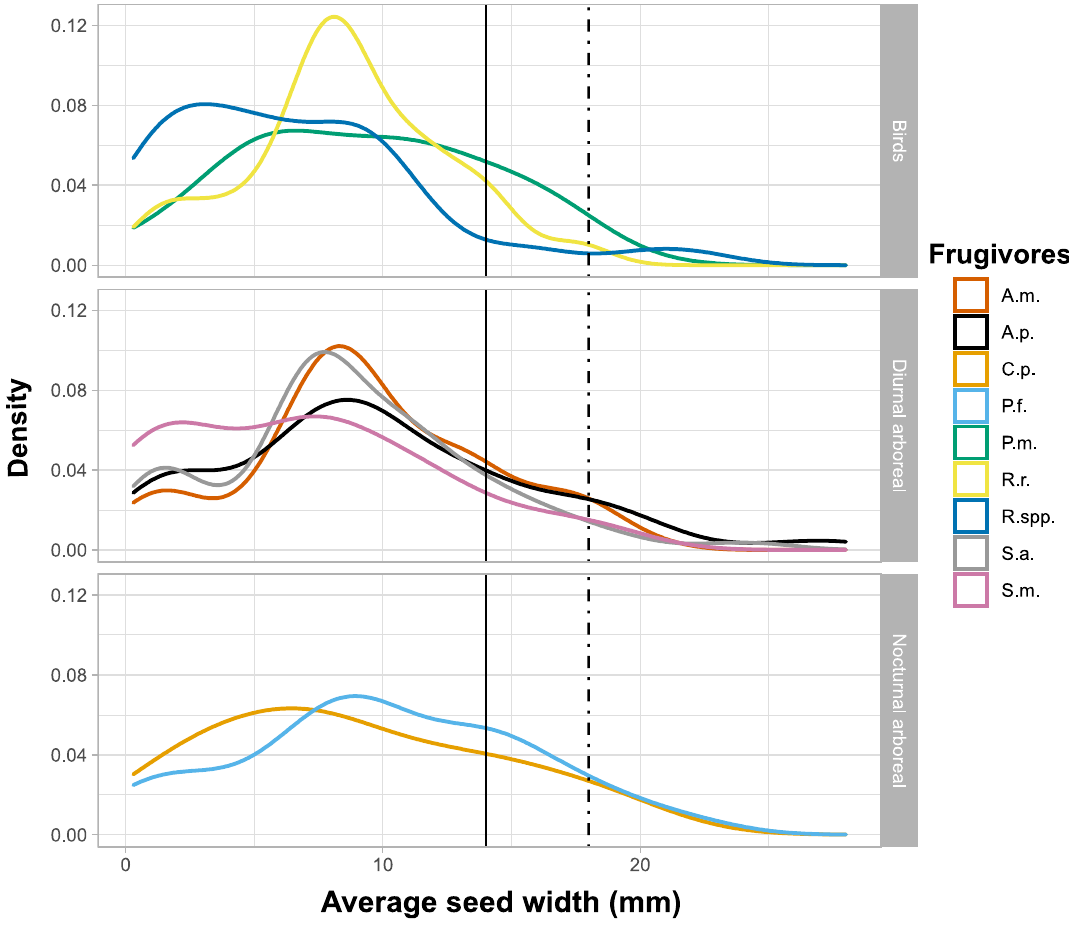
Figure 4. Density plot of average seed width (mm) dispersed by major neotropical arboreal frugivores. Data are obtained from literature based on studies in French Guiana, except for data on Ramphastidae spp., which were compiled from studies in the Atlantic Forest. Solid black line = average Virola michelii seed width. Dashed line = average Virola kwatae seed width. A.m. = Alouatta macconnelli ; A.p. = Ateles paniscus; C.p. = Caluromys philander; P.f. = Potos flavus; P.m. = Penelope marail; R.r. = Rupicola rupicola; R. spp. = Ramphastidae spp. ; S.a. = Sapajus apella; S.m. = Saguinus midas . Data for Virola seed size are from Ratiarison & Forget (2013) 12